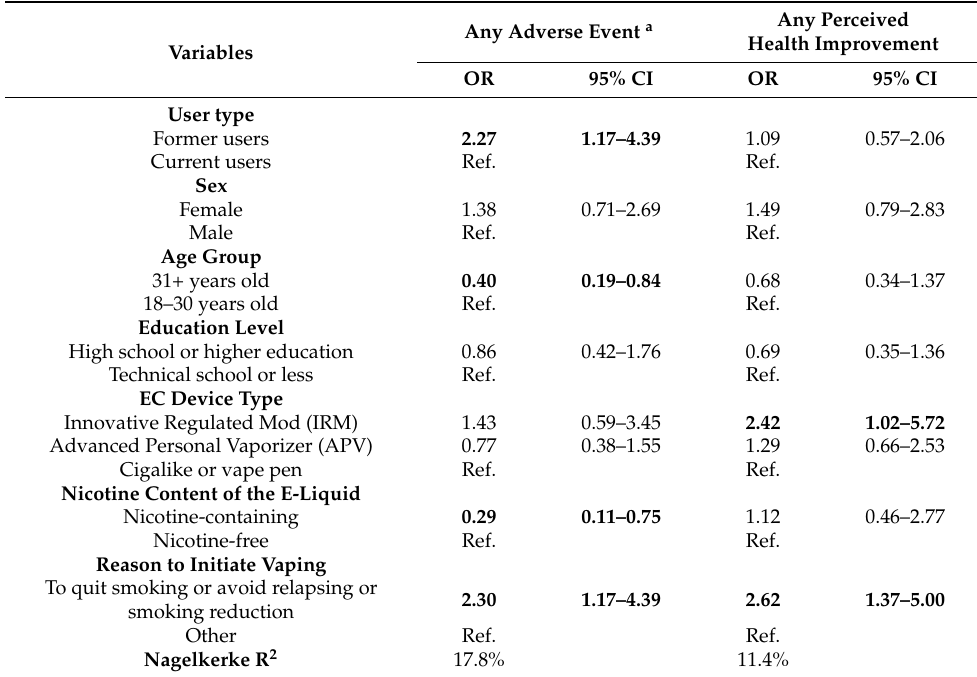
Table 5. Predictors of adverse events and perceived health improvement due to e-cigarette use among current and former daily users: multiple binary logistic regression